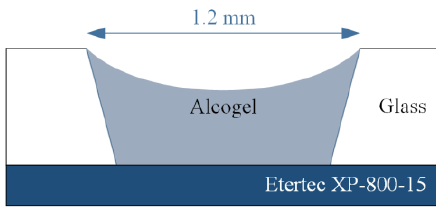
Figure 1. Cross section of the sandblasted borosilicate glass chip with the dry-film-resist Etertec XP-800-15 as a bottom layer. The 1.2 mm hole (not to scale) is filled with the silica sol and gelation to